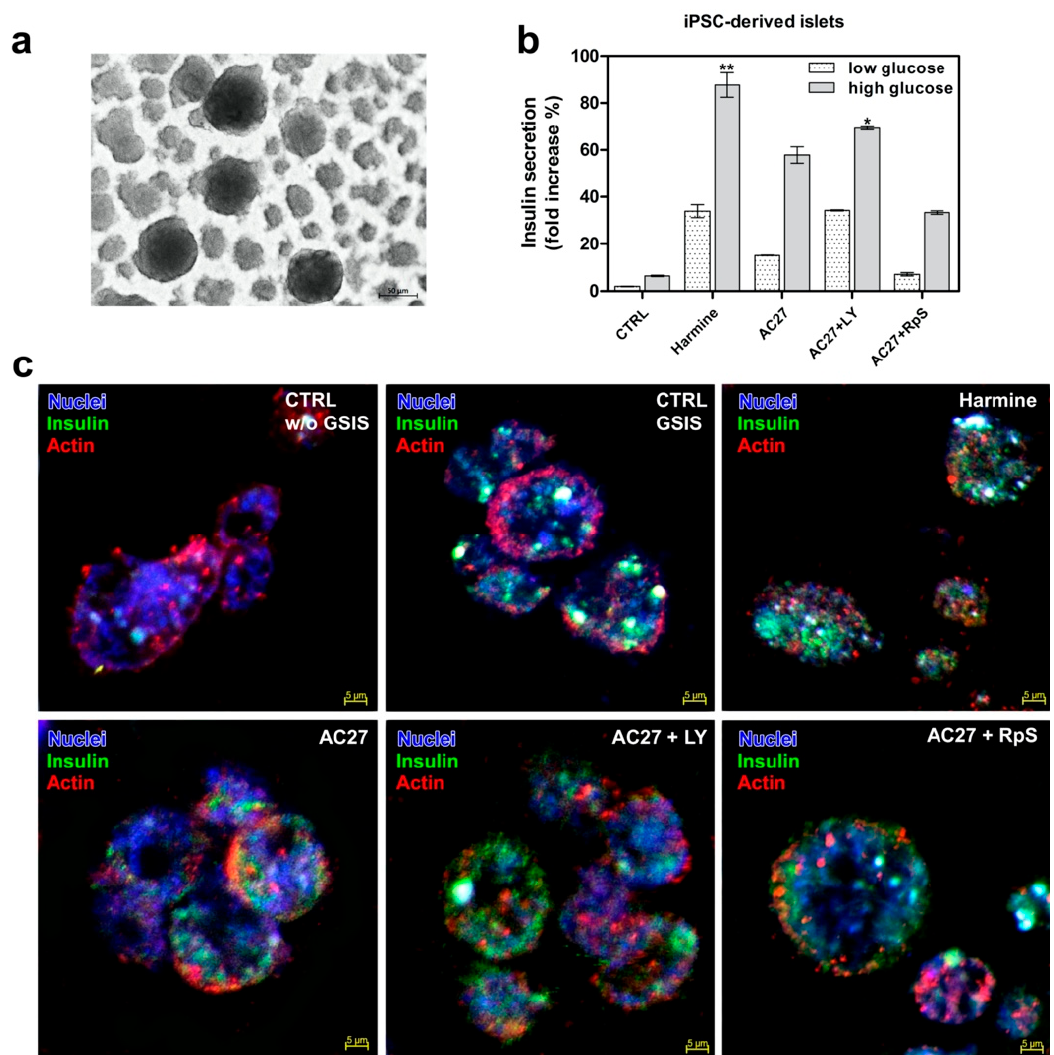
Figure 11. Development of hiPSC-derived β -cells organoids. ( a ) Morphology critical to directed differentiation-brightfield images of hiPSC spheres from seeding, day 21 of the differentiation protocol. Images show the morphology of the spheres important to ensure the correct directed differentiation to β -cells. ( b ) The insulin secretion assay was performed by incubating islets with harmine or AC27 (alone, or with RepSox or LY364947) at basal (2 mM, dotted bars) and high (25 mM, grey bars) glucose concentration. Values are normalized to the total amount of insulin, and insulin secretion is shown as a fold increase where the basal level is set at 1. Data are presented as the arithmetic mean ± SEM. ( c ) Representative immunostaining of hiPSC-like organoids stained for insulin (INS, green), actin (red) and Hoechst 33342 (blue). Scale bars, 10 µ m. Data are expressed as mean ± SEM. * p < 0.05, ** p < 0.01, *** p < 0.001; as compared to